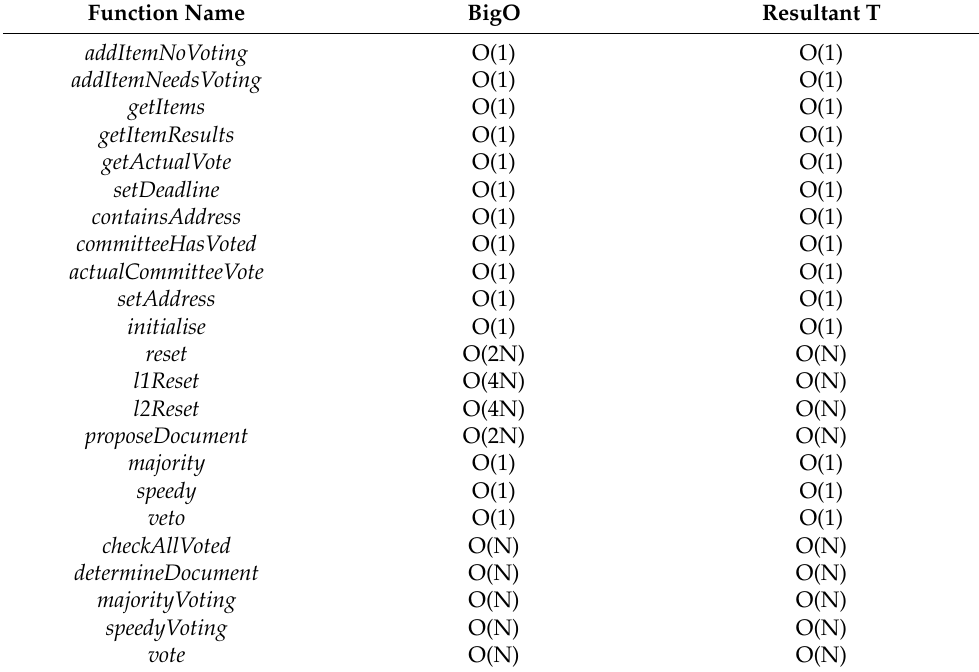
Table 2. SmartMinutes BigO of